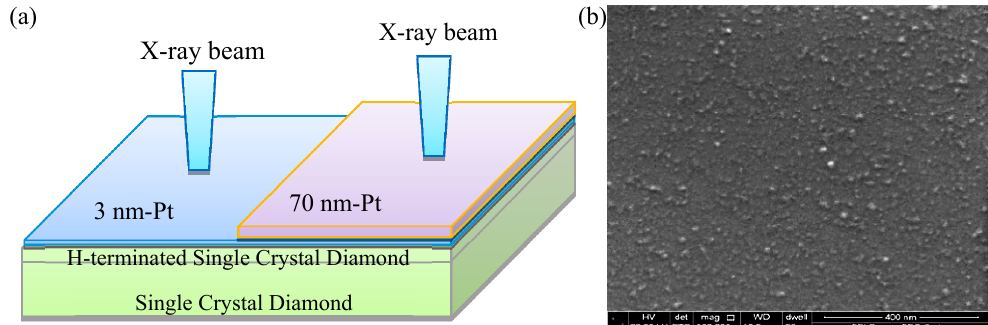
SEM image of the 3 nm Pt deposited on the diamond film. Figure 5. ( a ) Schematic diagram for the measurement of barrier height of Pt/H-SCD (100) by XPS, ( b ) Figure 5. ( a ) Schematic diagram for the measurement of barrier height of Pt / H-SCD (100) by XPS,